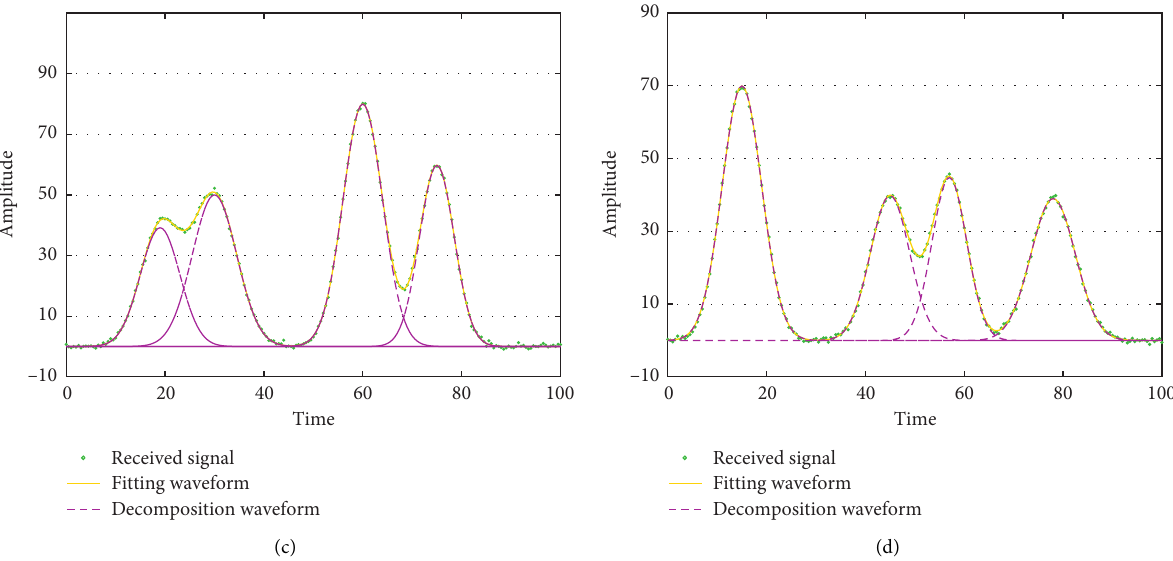
Figure 1: Decomposed waveforms obtained for groups (a) 1, (b) 2, (c) 3, and (d) 5.